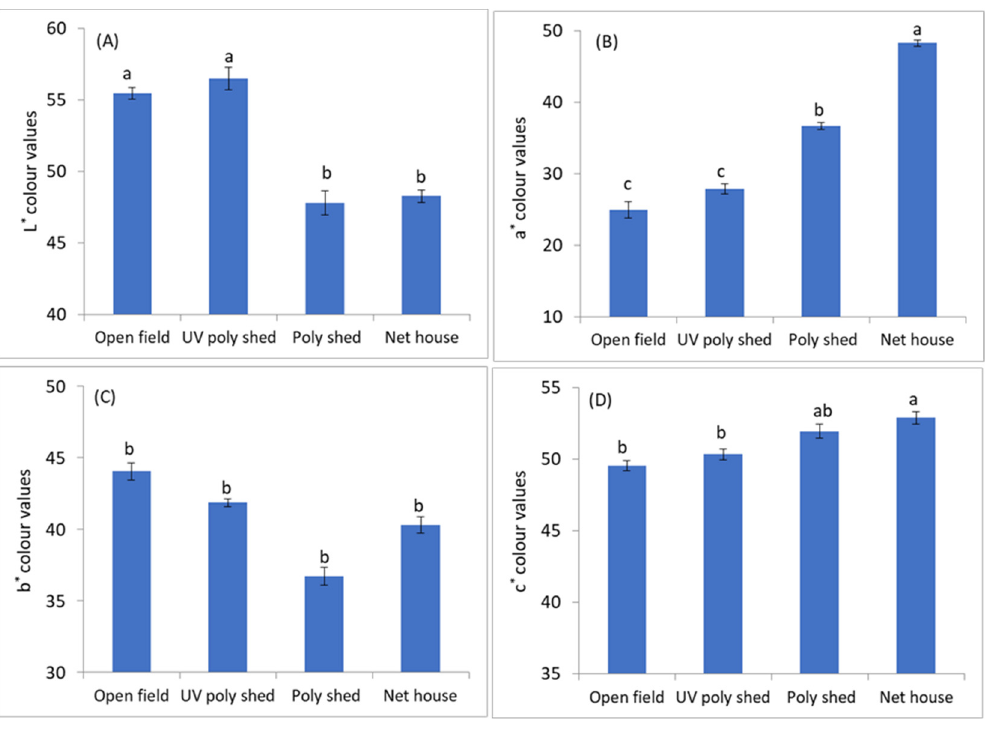
Figure 7. Average color values of L* ( A ), a* ( B ), b* ( C ), and C* ( D ) of papaya fruits at edible stage grown under different sheds and open field condition. Mean ± Standard error (S.E.) ( n = 15). Means with the same lower case letter are not significantly different at p = 0.05 by Duncan’s multiple range test.